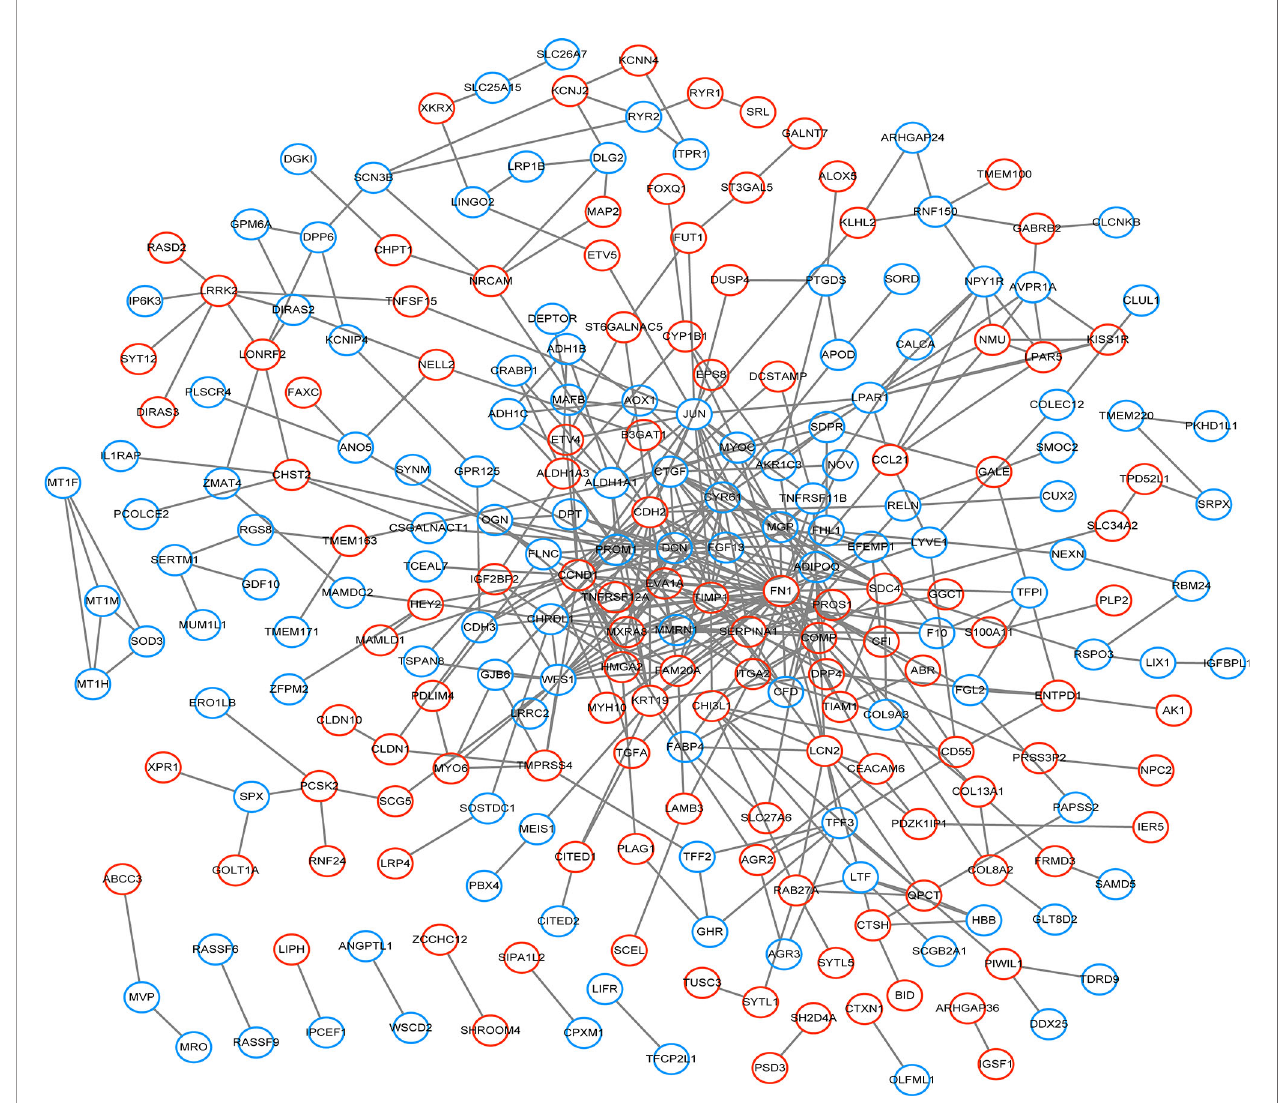
FIGURE 4 | The PPI network of DEGs was constructed using Cytoscape. Red circles represent upregulated genes, while blue circles represent downregulated